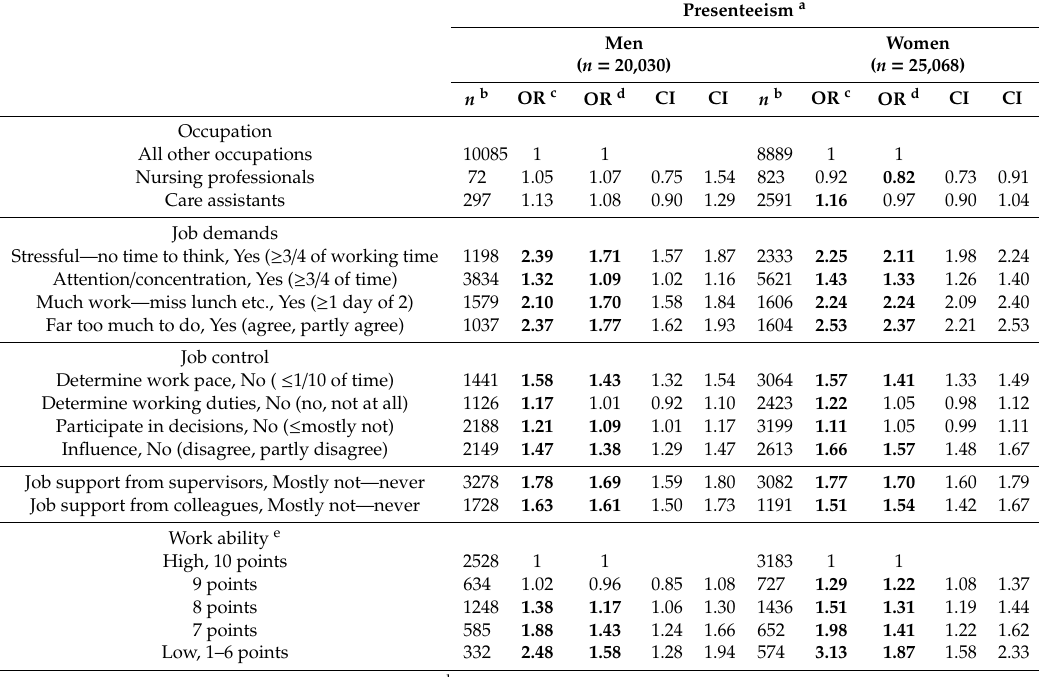
Table 3. Associations between presenteeism (two times or more) and occupation, work ability, and psychosocial variables stratified by sex. Number of cases and odds ratios (ORs) with 95% confidence intervals (CIs) are